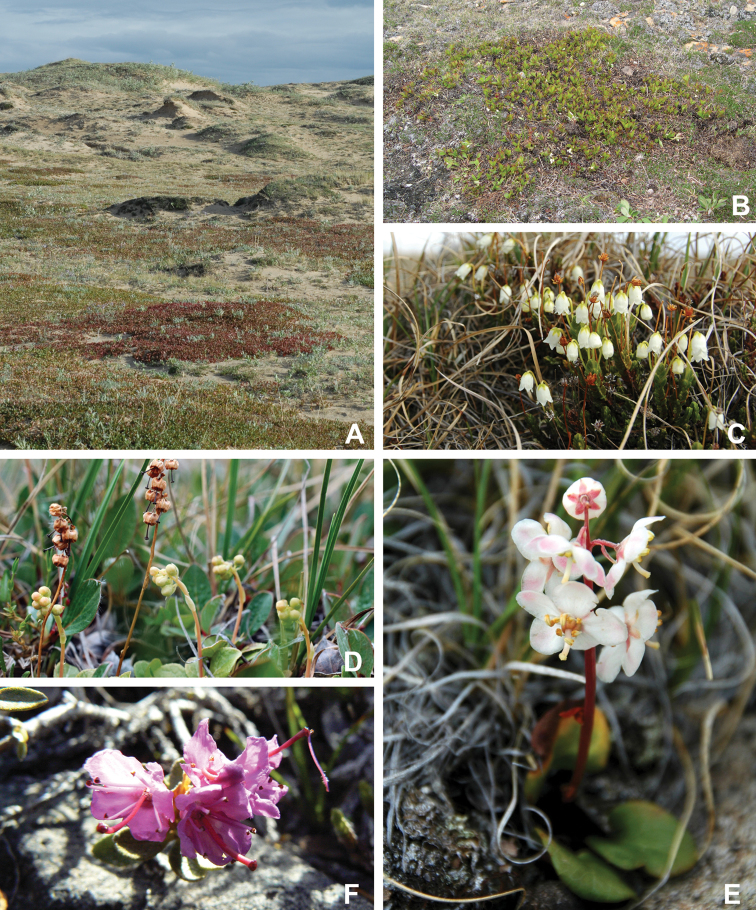
AArctous
rubra habitat, Gillespie et al. 9884BArctous
rubra habit, Gillespie et al. 7714CCassiope
tetragona
subsp.
tetragona habit, Oterkvik Point, NU, 3 July 2008 DOrthilia
secunda
subsp.
obtusata habit, Gillespie et al. 8712EPyrola
grandiflora
subsp.
grandiflora habit, Gillespie et al. 7967FRhododendron
lapponicum Kuujjua River, NT, 16 July 2010. Photos A, B by L.J. Gillespie C, D, F by R.D. Bull and E by P.C. Sokoloff.